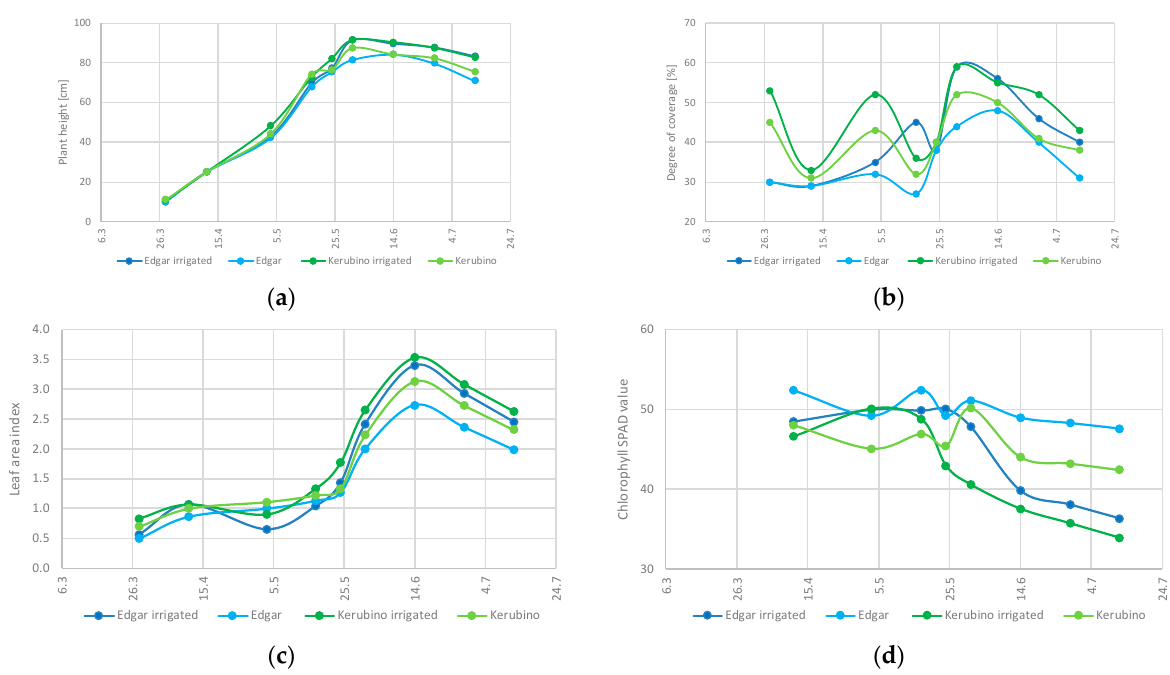
Figure 5. Measurements of the biometric parameters of the winter wheat varieties Opal and Kerubino on irrigated and unirrigated plots from March to July 2017; ( a ) plant height; ( b ) degree of coverage; ( c ) leaf area index; ( d ) chlorophyll SPAD value. Table 5. Growth stages (GS) of winter wheat varieties Opal, Edgar, and Kerubino on irrigated and unirrigated plots.